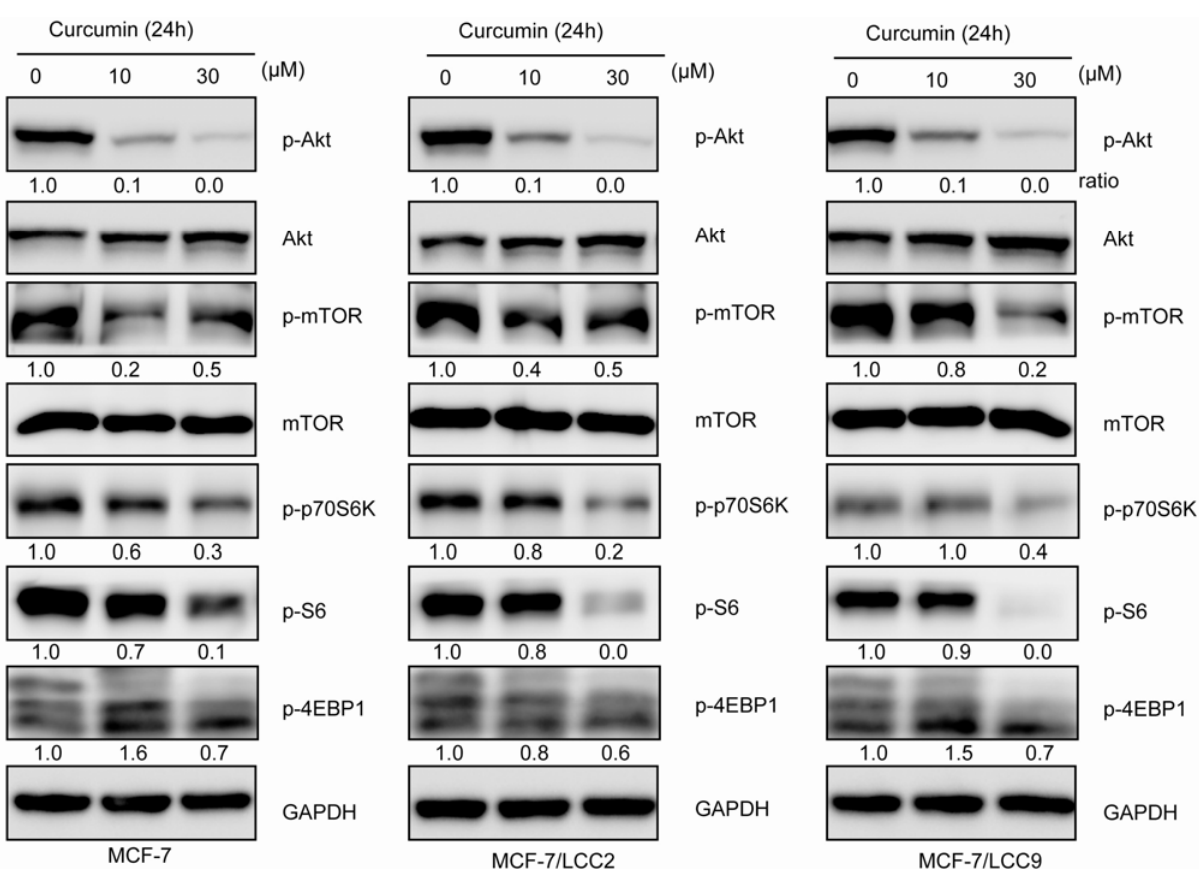
Figure 9. Curcumin inhibits Akt/mTOR pathway in MCF-7/LCC2 and MCF-7/LCC9. Cells were incubated with indicated concentrations of curcumin and then analyzed by western blot for detecting Akt, p-Akt (Thr308), mTOR, p-mTOR(Ser2488) and their downstream signals: 4EBP1, p-4EBP1(Thr37/46), S6, p-S6 (Ser235/236), p70S6K and p-p70S6K (Thr389). Data about 4EBP1, S6 and p70S6K was not